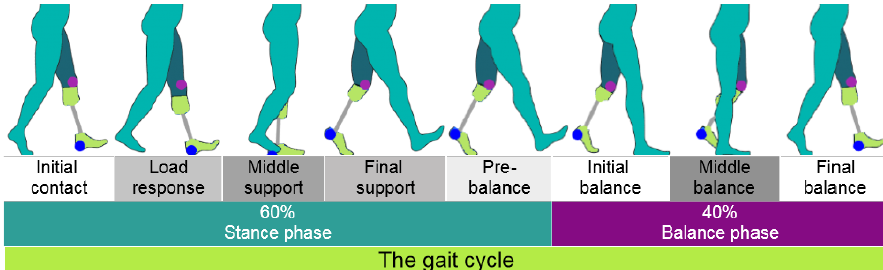
Figure 2. The two main gait cycle phases with the key support and balance subphases of the residual left lower limb with a transtibial prosthesis.